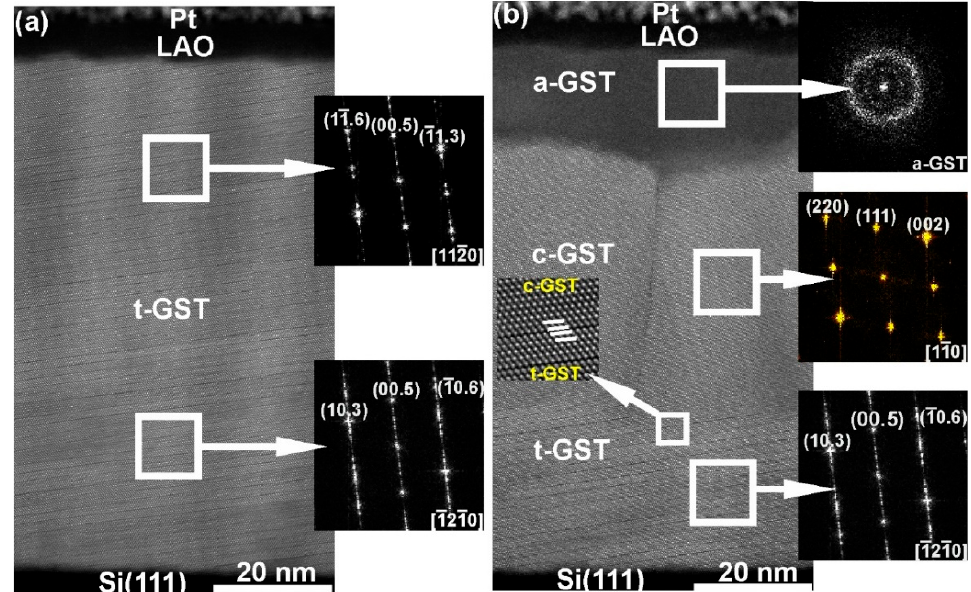
Figure 7. HAADF-HRSTEM images: ( a ) as-grown epitaxial t-GST thin film on Si (111) substrate with 6° miscut and ( b ) after laser irradiation by a single ns-laser pulse of a fluence of 23 mJ/cm 2 . The insets show FFT patterns calculated form rectangles marked in the images. The FFT patterns confirm the epitaxial relationship between the t-GST and the c-GST structures. At the bottom of the GST thin film in ( b ), the initial structure of epitaxial t-GST is preserved, whereas c-GST is formed in the middle of the thin film. At the top of the GST thin film, the material is melt-quenched into the amorphous phase. The insert in ( b ) gives a magnified image of the c-GST/t-GST interface, where white lines mark the (111) and (0001) lattice planes in the c-GST and t-GST structures, respectively.